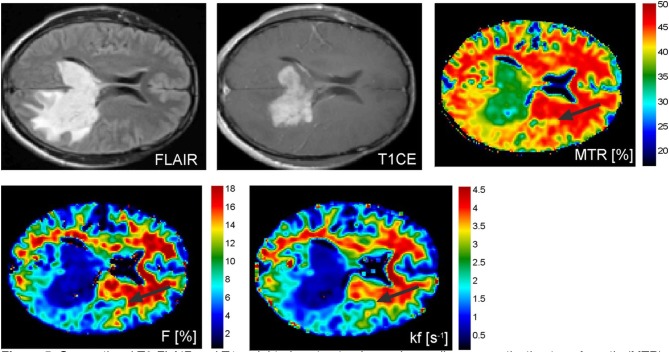
Conventional T2-FLAIR and T1-weighted contrast-enhanced as well as magnetization transfer ratio (MTR), macromolecular concentration (F), and exchange rate between the bound protons and free water protons (kf) images of a patient with a malignant pleomorphic glial tumor in the left temporal and occipital lobes showing contralateral tumor extension via the splenium of the corpus callosum. Abnormal MTR values can be discerned ventrally and laterally to the altered looking tissue on conventional MRI (black arrows). Reproduced, with permission, from Garcia et al. (35).